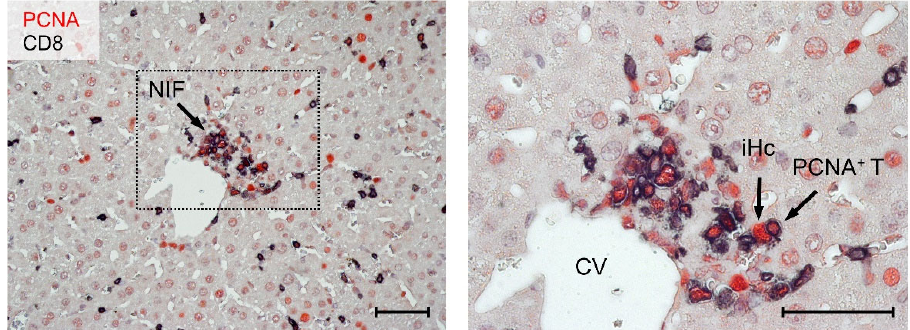
Figure 5. 2C ‐ IHC images showing proliferating CD8 T cells accumulated in a perivascular nodular inflammatory focus (NIF). Liver tissue-infiltrating CD8 T cells are identified by black staining of the CD8a molecule. Proliferating CD8 T cells are identified by red nuclear staining of PCNA and black cytoplasmic as well as membrane staining of CD8a. Infected liver cells, which are primarily hepatocytes, also express PCNA in their nuclei. ( Left image ) lower ‐ magnification overview. ( Right image ) the framed area in the overview image is resolved to greater detail. Light hematoxylin counterstaining reveals the context of liver tissue. CV—central vein; iHc—infected hepatocyte; PCNA + T—proliferating PCNA + CD8 T cell. Bar markers, 50 μ m.